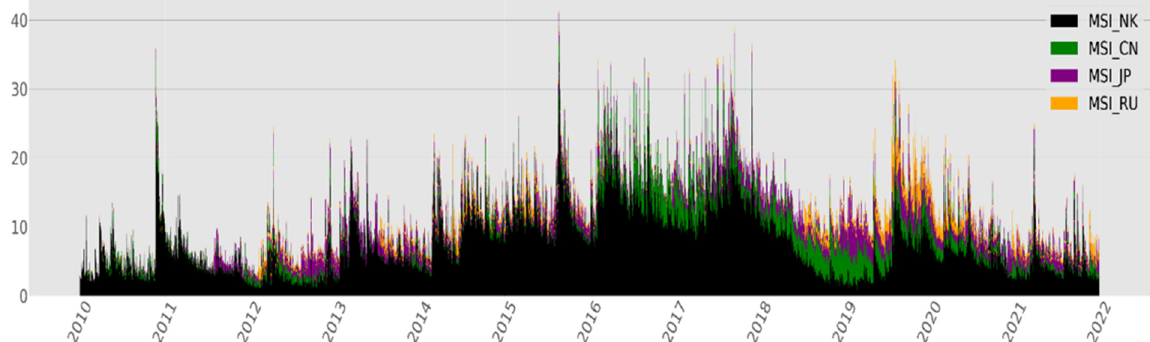
Figure 13. Total Military Security Index by Country (‘10 ∼ ’21).